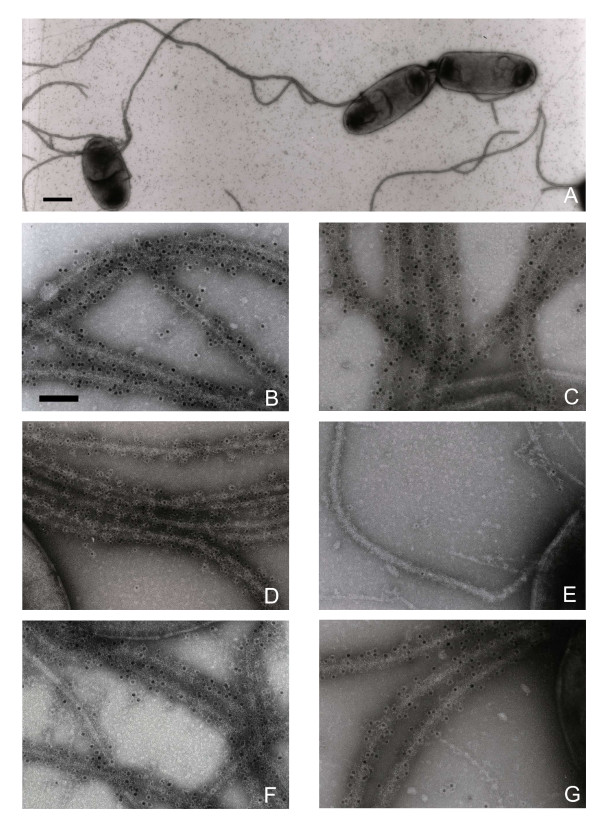
(A) Low power micrograph of E. coli strain TPE1978 cells showing the density of the bacterial samples used for indirect IEM and the presentation of flagella (bar length = 1 μm) (B) IEM of strain TPE1978 flagella after incubation with rabbit flagellar H48 antiserum (1:1000) and detection of bound antibody by anti-rabbit-IgG- 10 nm gold (1:20), bar length = 100 nm. (C) Strain JM109 flagella after incubation with rabbit flagellar H48 antiserum and detection of bound antibody by anti-rabbit-IgG- 10 nm gold. (D) Strain TPE1978 flagella after incubation with rabbit flagellar H4 antiserum (1:1000) and detection of bound antibody by anti-rabbit-IgG- 5 nm gold. (E) Strain JM109 flagella after incubation with rabbit flagellar H4 antiserum and detection of bound antibody by anti-rabbit-IgG- 5 nm gold. (F) Double-labeling IEM of strain TPE1978 after sequential incubations with rabbit flagellar H4 antiserum and anti-rabbit-IgG 5 nm gold, followed by rabbit flagellar H48 antiserum detected by anti-rabbit-IgG- 10 nm gold. Both, 5 nm and 10 nm gold markers are bound at comparable amounts over all flagella present on the bacteria. (G) Double-labeling IEM of strain JM109 after sequential incubations with rabbit flagellar H4 antiserum and anti-rabbit-IgG- 5 nm gold followed by rabbit flagellar H48 antiserum and anti-rabbit-IgG- 10 nm gold. Only H48 specific (10 nm) gold particles are bound to the flagella of JM109.